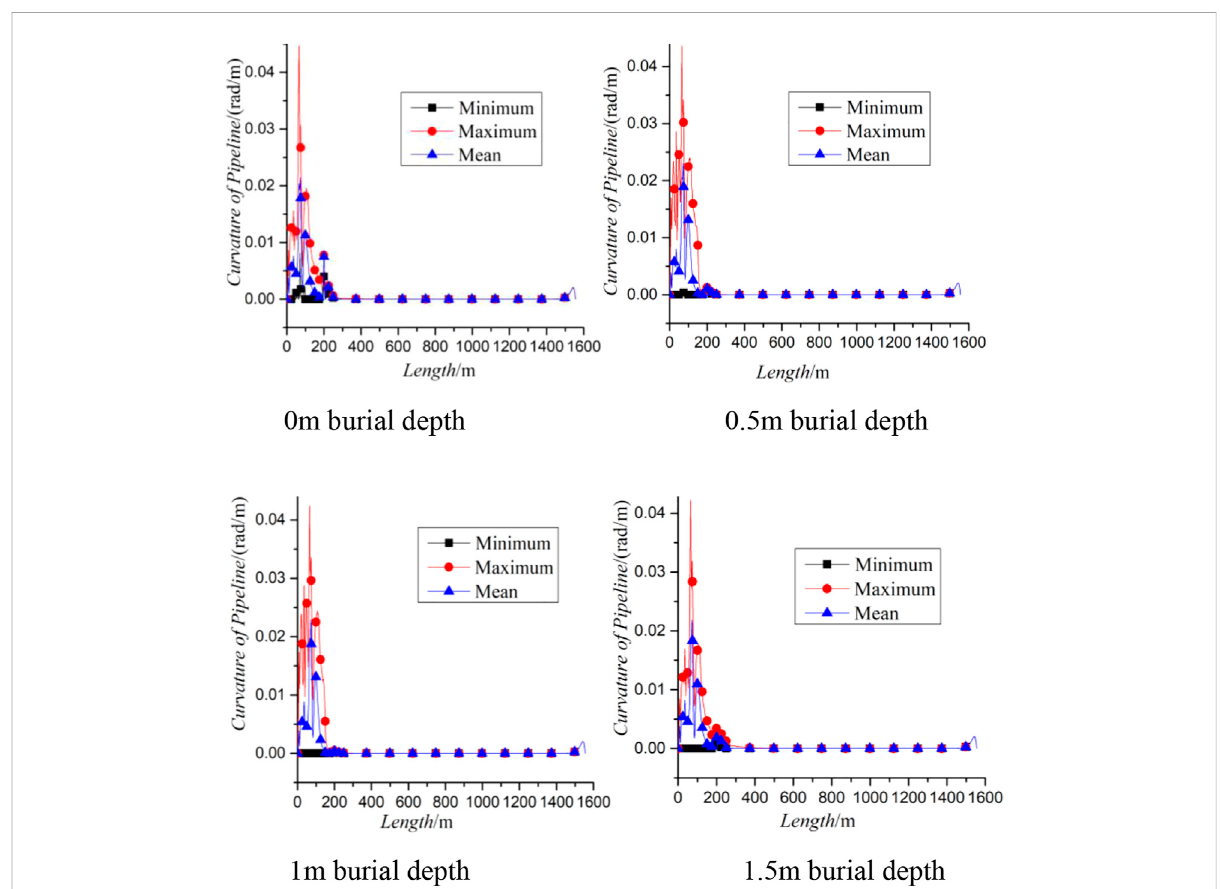
FIGURE 12 Curvature of the pipeline in the length direction with different burial